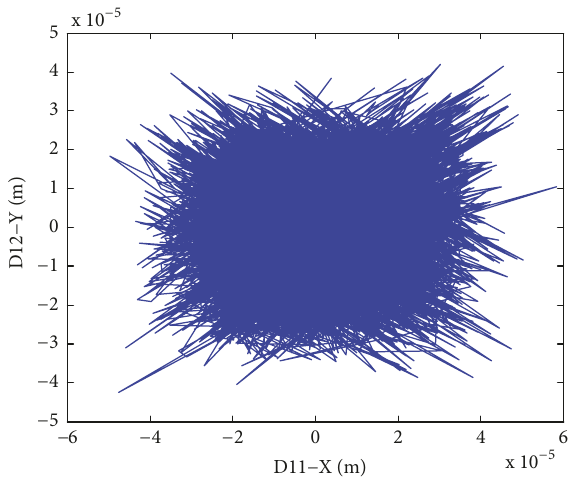
Figure 10: A-end face of the D11 and D12 sensors to collect the signal directly synthesized axis orbit.